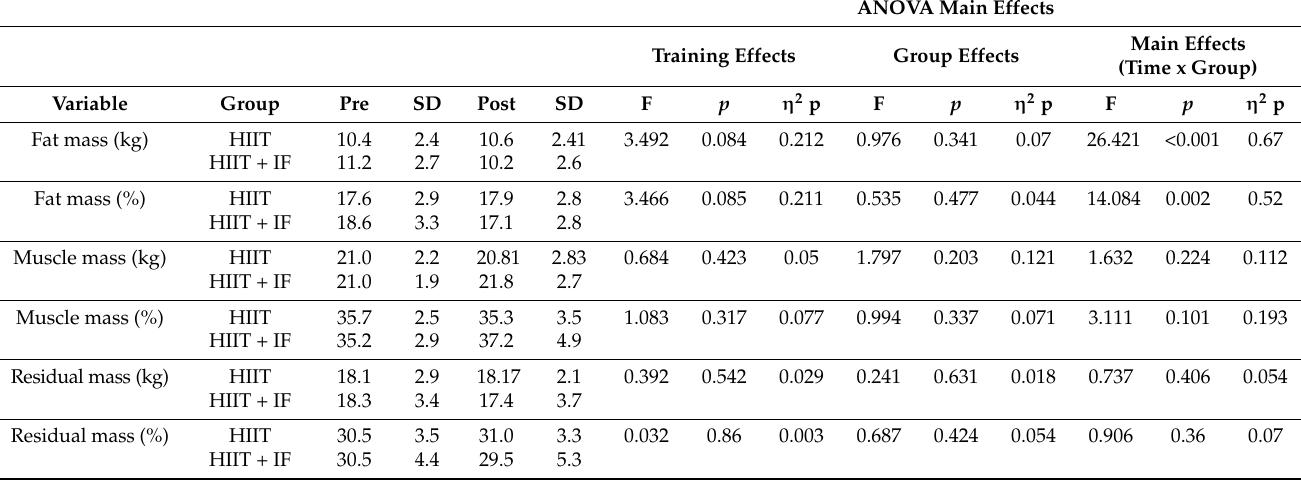
Table 2. Changes in body